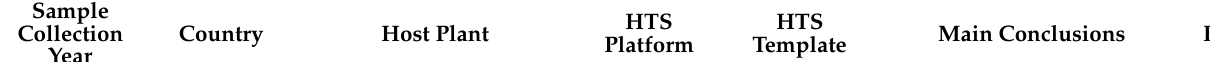
Table 1. Studies using metagenomic approaches for virus detection and diversity in weeds and wild plants. Sample